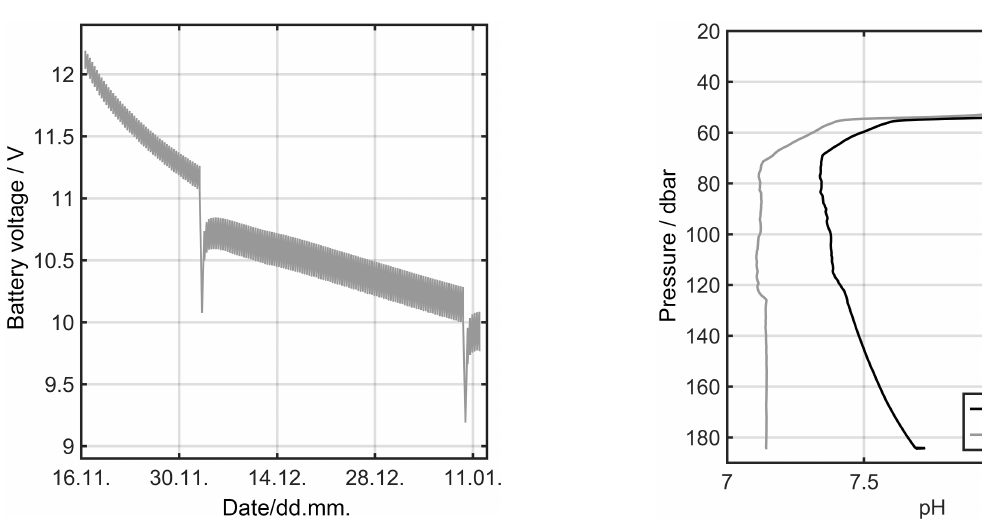
Figure 11. Two successive profiles of pH, taken before the CTD failed to switch off power to the external sensors (2 December, 22:00UTC, black) and 8h later after sensors had been powered for 8h (3 December, 06:00UTC,